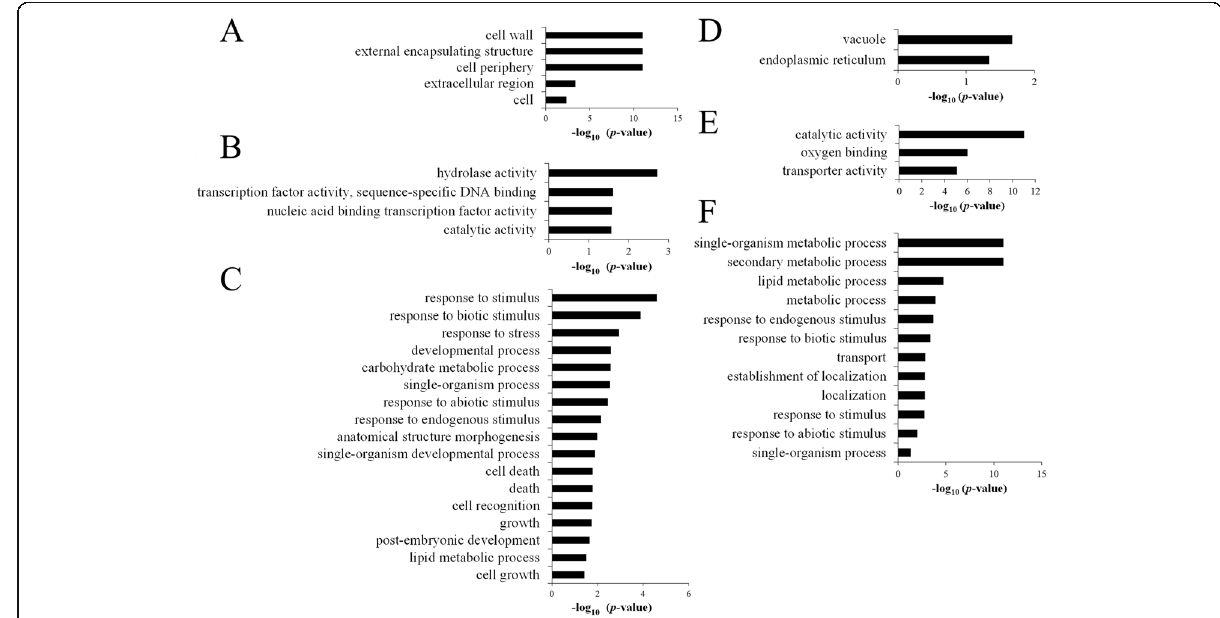
Fig. 3 Gene Ontology (GO) analysis for differentially expressed genes (DEGs). a , Significant cellular component GO terms of the up-regulated DEGs. b , Significant molecular function GO terms of the up-regulated DEGs. c , Significant biological process GO terms of the up-regulated DEGs. d , Significant cellular component GO terms of the down-regulated DEGs. e , Significant molecular function GO terms of the down-regulated